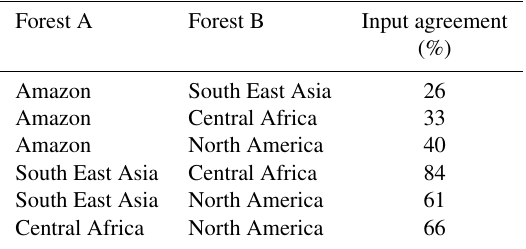
Table 3. Amount of overlap in NROY input space for forest com-